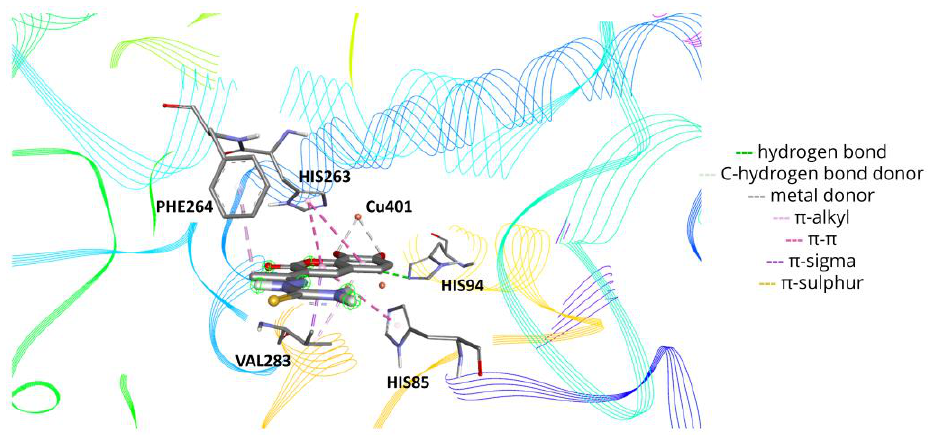
Figure 6. Docked pose of T6 in the catalytic MTa site and intermolecular interactions with the surrounding residues of mushroom tyrosinase.